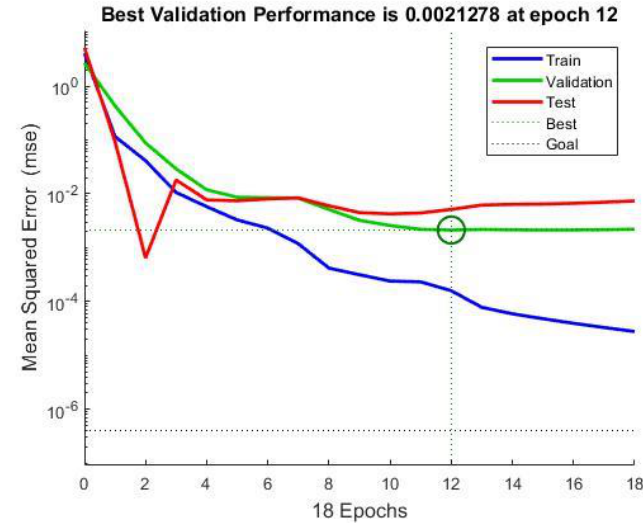
Figure 16. The performance of the neural network.